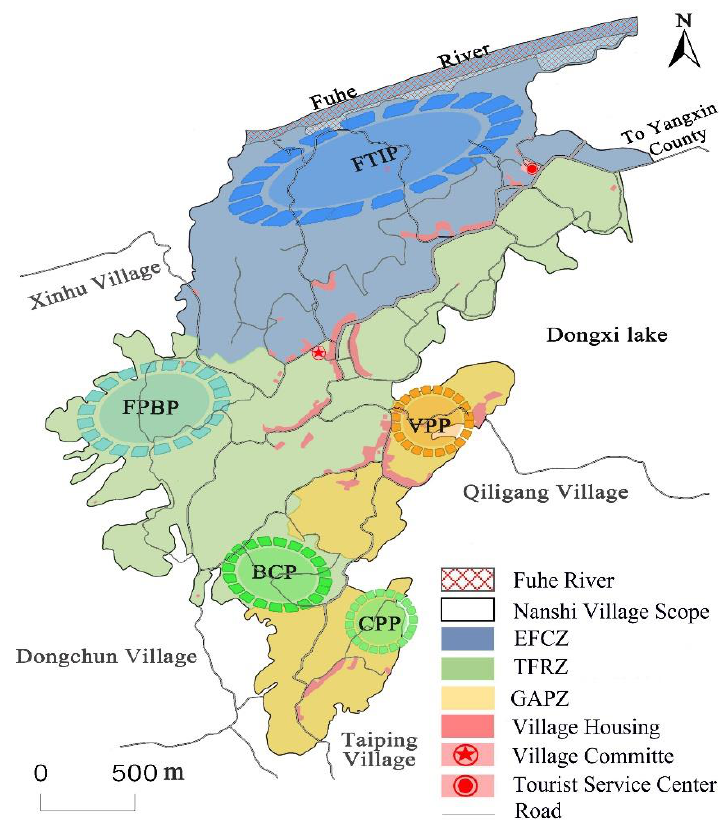
Figure 3. Industrial development space zoning in Nanshi Village.